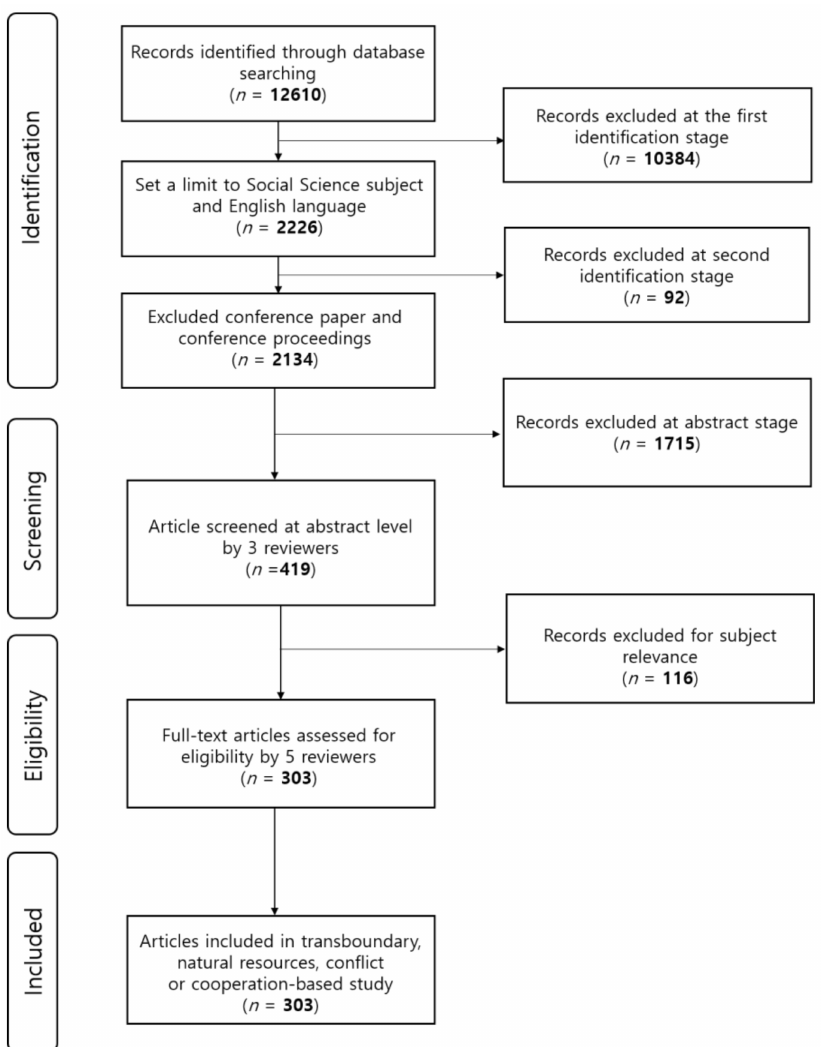
Figure 2. Process overview of the systematic